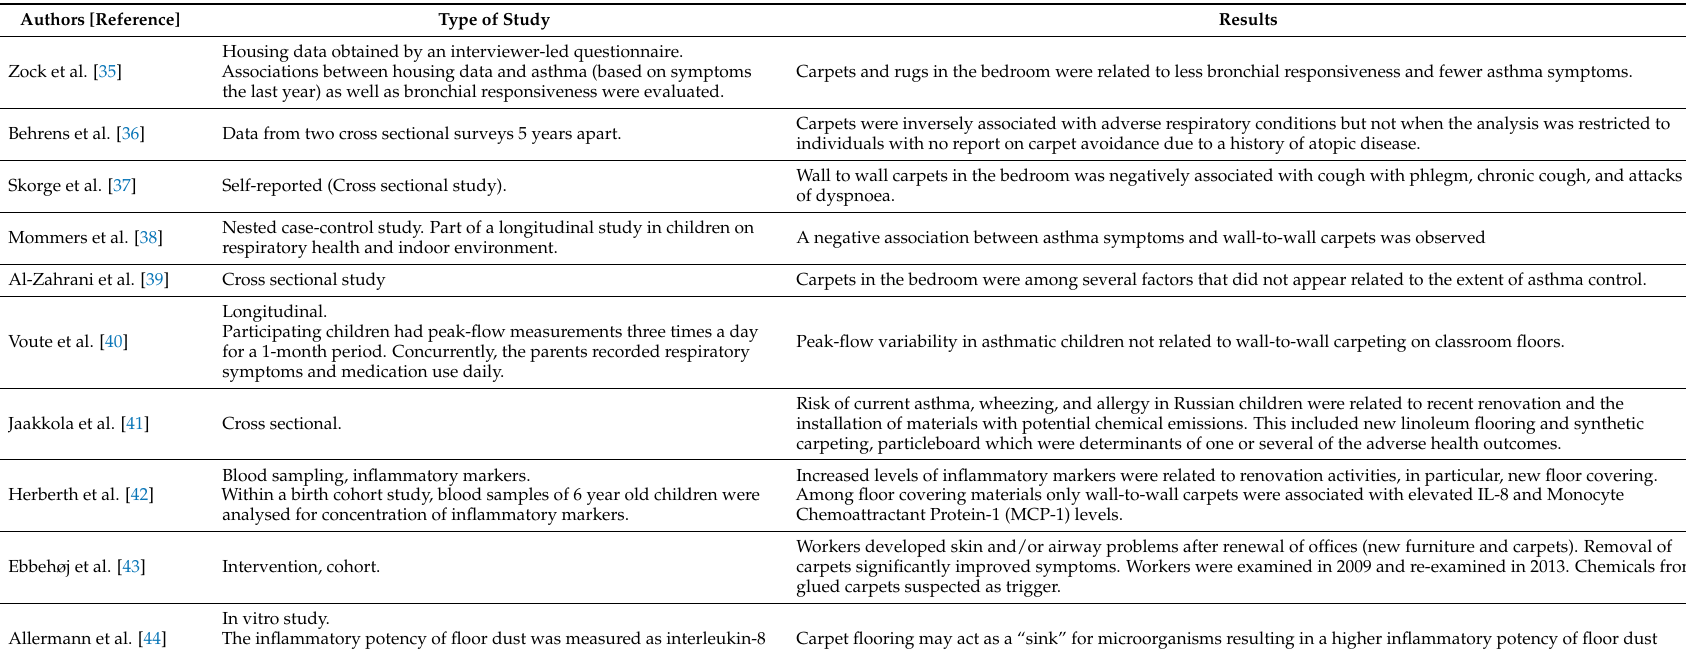
Table 2. Associations between carpet use and adverse health